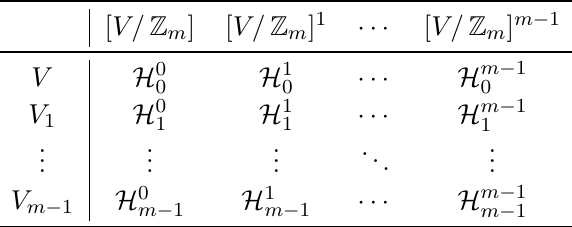
Table 1 . The holomorphic VOA V decomposes as a direct sum of the untwisted Hilbert spaces, where the upper grading denotes the “electric” Z m charge. The orbifold VOA decomposes as a direct sum of the gauge invariant Hilbert spaces, where the lower index grading denotes the dual “magnetic” ˆ Z m